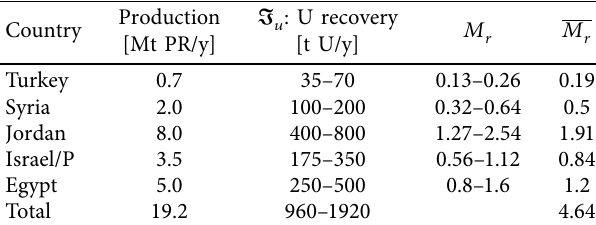
Table 7: Current realistic potential for uranium self sufficiency in some countries of the